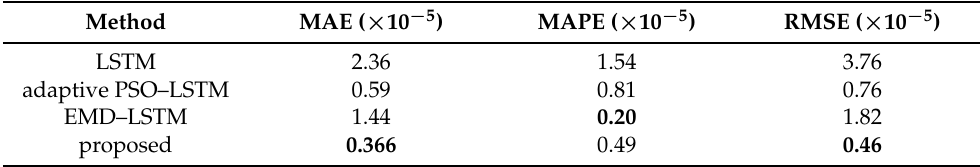
Figure 23. Pitch angle prediction error distribution of Dataset 2. Table 6. Statistical results of pitch angle prediction errors in Dataset 1.